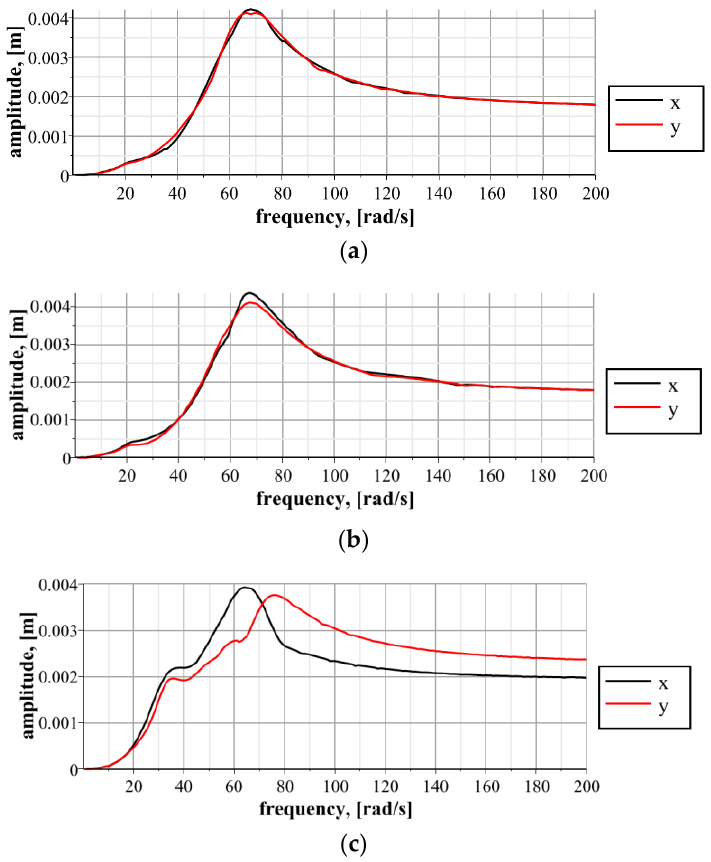
Figure 10. Amplitude – frequency characteristics of the vibratory system at the phase-shift angle 𝜑 = 90° and under different synchronization conditions of ( a ) 𝜔 2 = 𝜔 1 ; ( b ) 𝜔 2 = −𝜔 1 ; ( c ) 𝜔 2 = 2𝜔 1 .